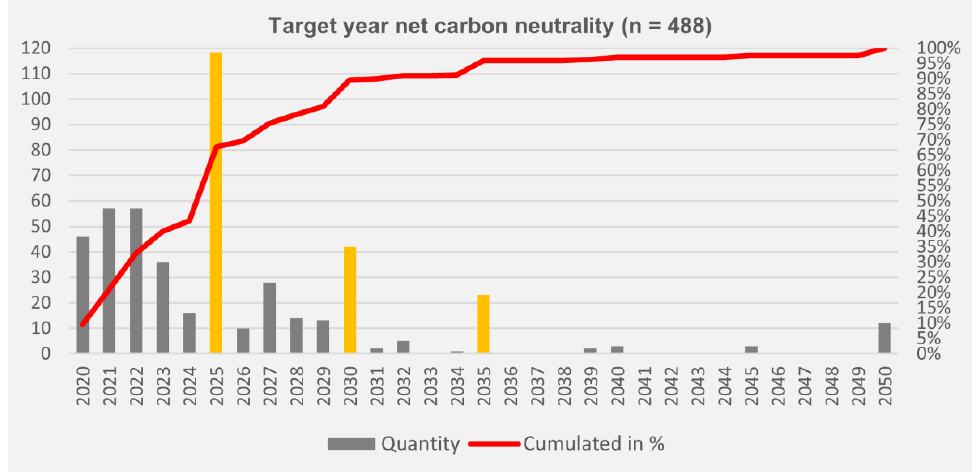
Figure 5. By when do companies plan to reach net carbon neutrality?